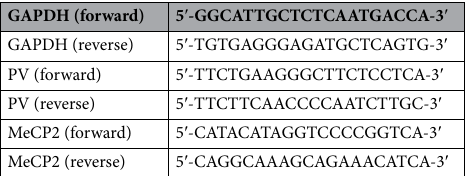
Table 1. Primer set for qPCR.